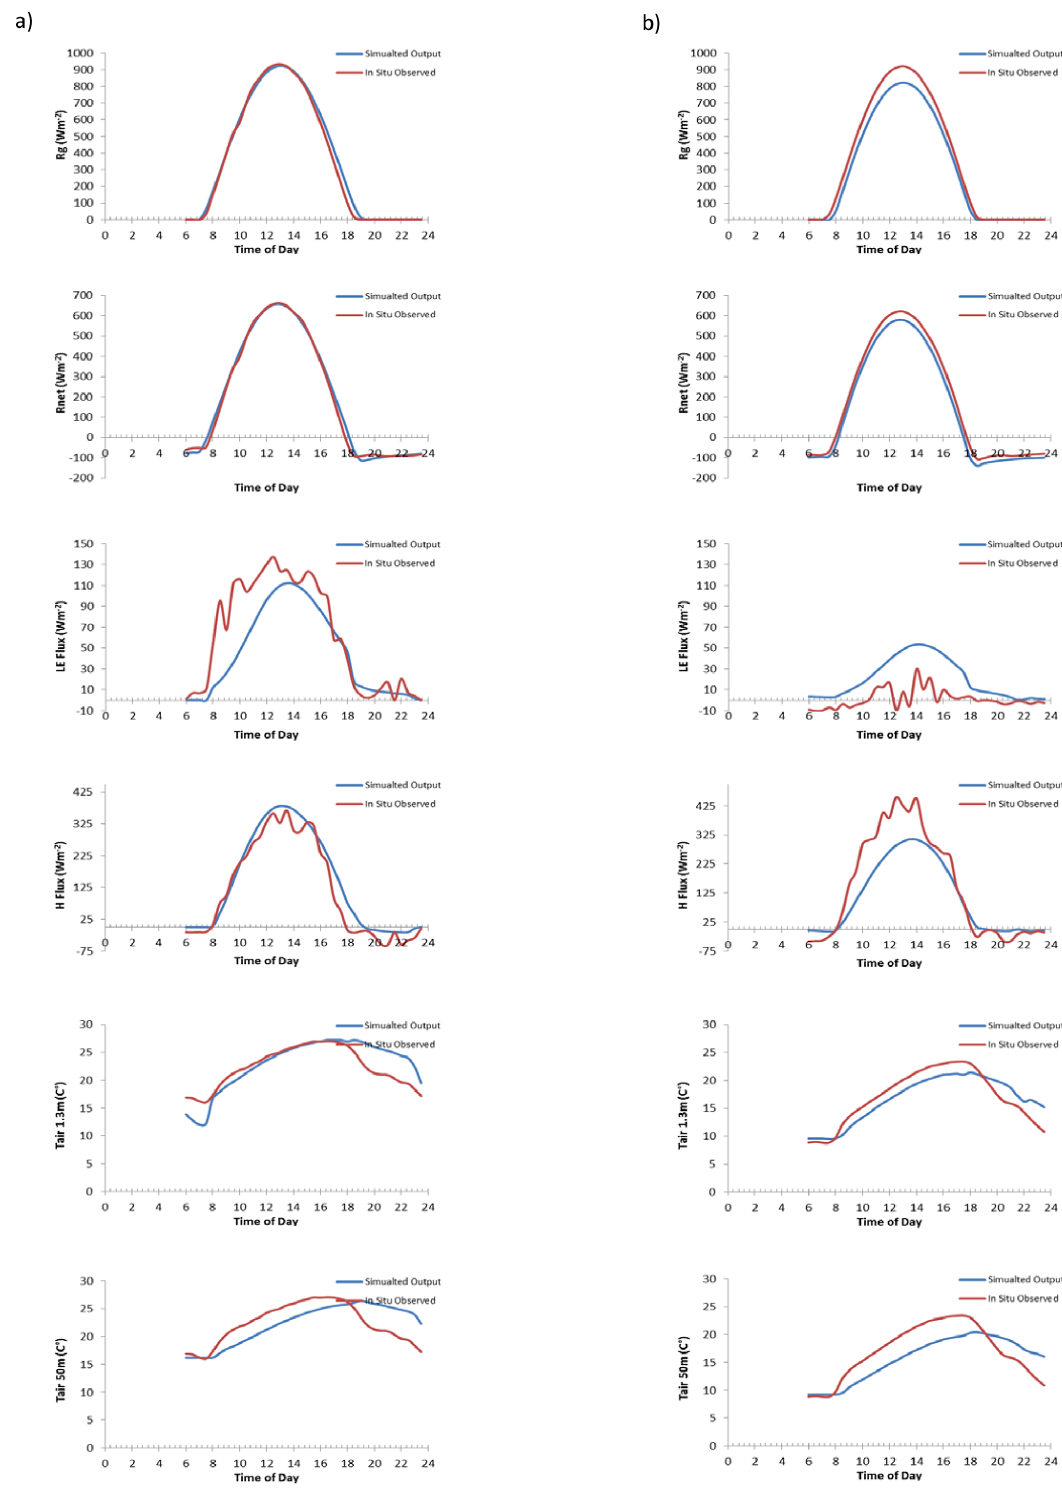
Figure 3. Simulated and observed fluxes for the Alice Springs site (shrubland); (a) illustrates the diurnal trend of the simulated fluxes from SimSphere against the observed in situ fluxes for 15 April 2011 (spring); (b) illustrates the diurnal trend of the simulated fluxes from SimSphere against the observed in situ fluxes for 20 August 2011